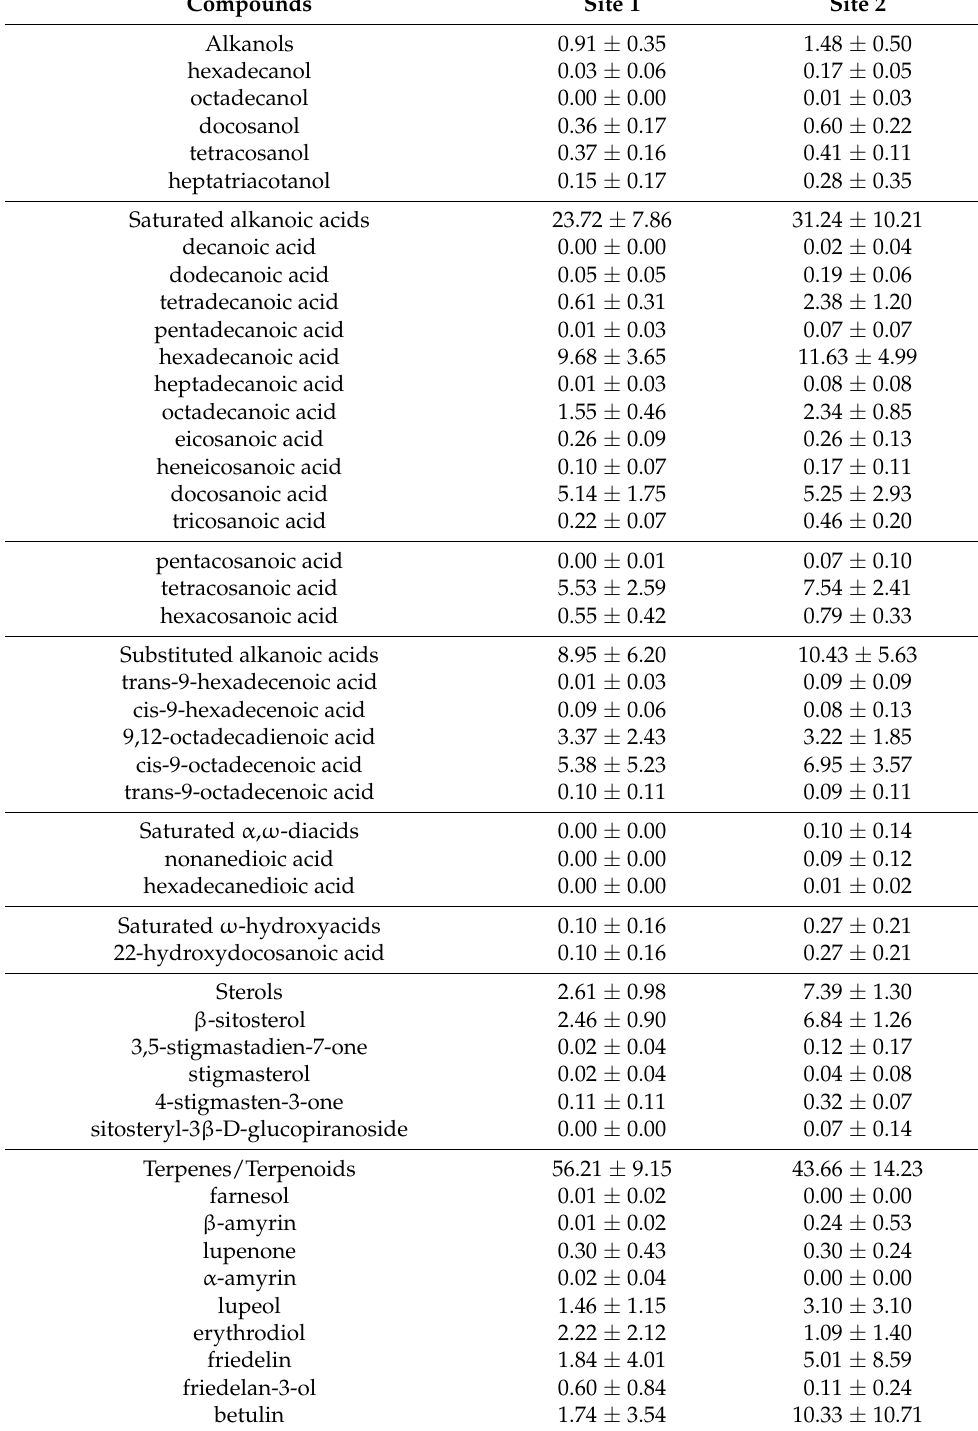
Table 5. Composition of dichloromethane extracts from Quercus rotundifolia bark sampled at b.h. from trees grown at two sites, in % of the normalized peak areas in TIC (mean of five trees and standard